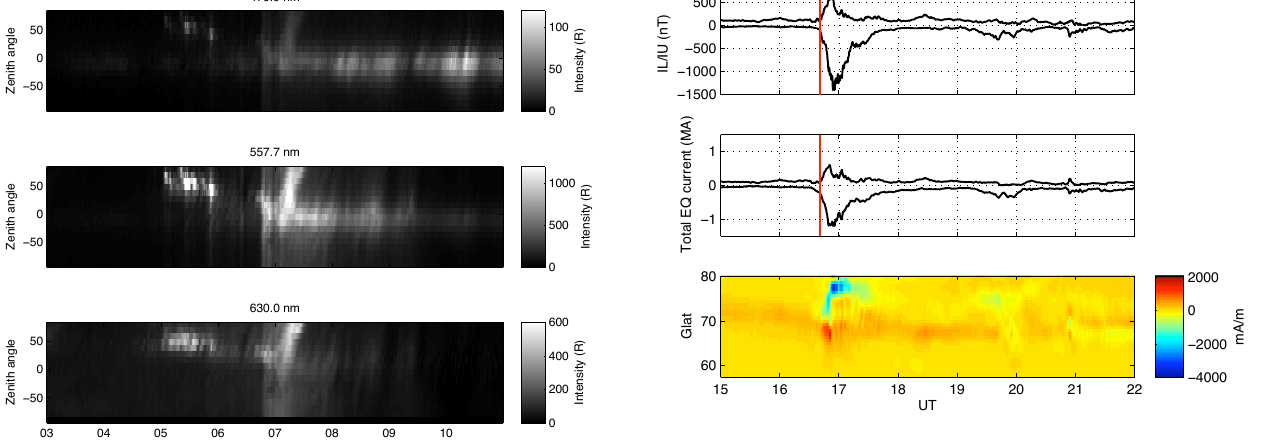
Fig. 6. Ground-based measurements during the storm main phase substorm (substorm 2) as a function of Universal Time. Panels from top to bottom: (1) auroral electrojet index (upper and lower) calcu- lated from the IMAGE network, (2) strength of the total electro- jet currents (eastward positive, westward negative) estimated from the magnetometer data, and (3) electrojet current density deduced from magnetometer recordings by 1-D upward continuation method (green/blue colours for westward and yellow/red colours for east-